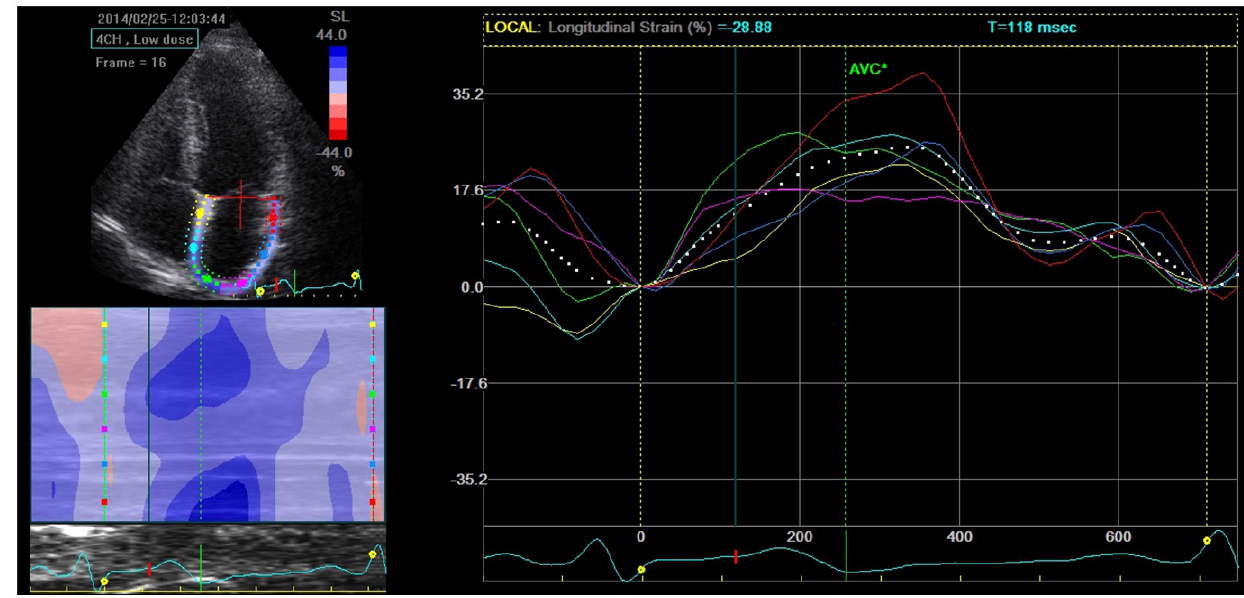
Analysis of blood samples After fasting overnight for 12 h, venous blood samples were obtained for all patients from the antecubital space.